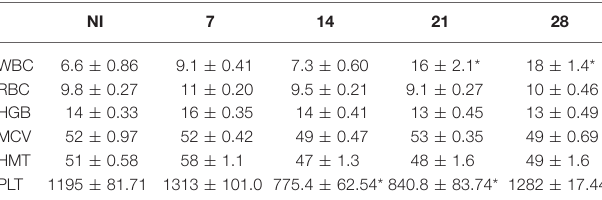
TABLE 1 | Blood counts of non-infected (NI) and orally T. cruzi infected (OI)